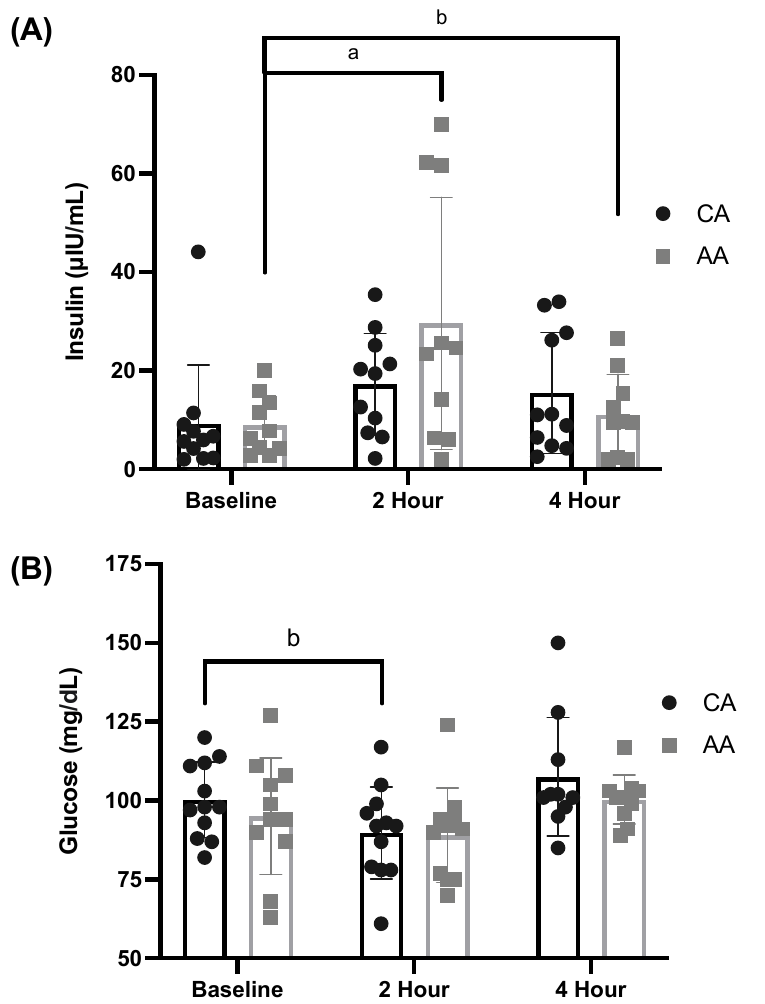
Figure 2. Baseline and postprandial insulin and glucose response to a high-fat meal in African American and Caucasian American females. ( A ) Insulin ( µ IU/mL) response to a high-fat meal (ANOVA: Time, p = 0.004, η p2 = 0.440; Group, p = 0.096, η p2 = 0.219; n = 23) and ( B ) glucose (mg/dL) response to a high-fat meal (ANOVA: Time, p < 0.001, η p2 = 0.633; Group, p = 0.875, η p2 = 0.016; n = 23). a p ≤ 0.05 compared to baseline for AA females and b p ≤ 0.05 compared to baseline for CA females. AA—African American; CA—Caucasian American.